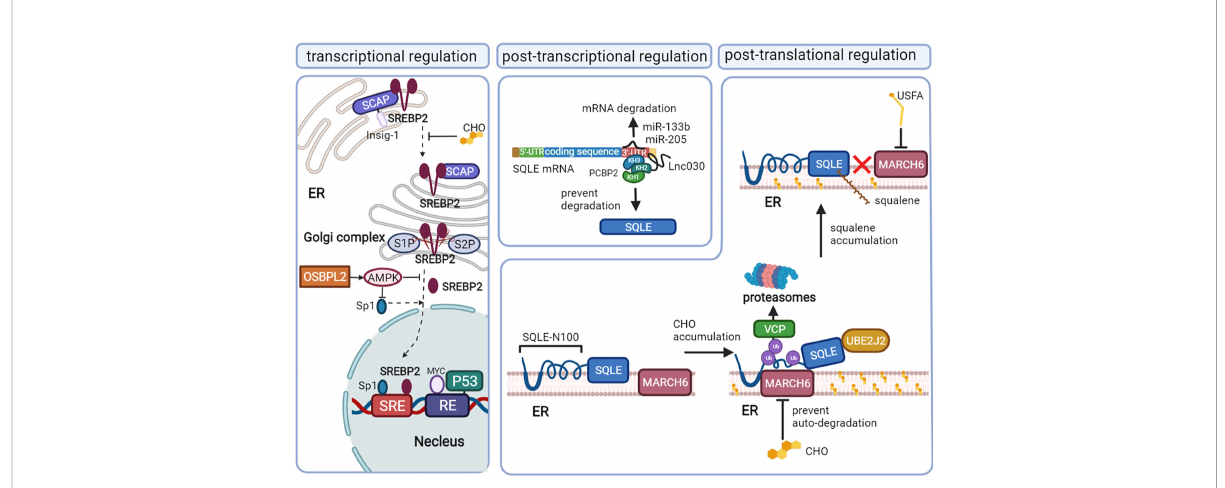
FIGURE 2 The mechanisms that regulate SQLE expression in cancer. Squalene monooxygenase (SQLE) can be regulated at the transcriptional level mainly via sterol regulatory element-binding protein 2 (SREBP2), the posttranscriptional level via microRNA (miRNA)/long noncoding RNA (lncRNA), and the posttranslational level via cholesterol feedback regulation. Mature SREBP2 promotes the transcription of SQLE by binding to the sterol- regulatory elements (SREs) of sqle (the gene encoding SQLE). When the cholesterol content in the endoplasmic reticulum membrane decreases, the SREBP2/SCAP complex dissociates from Insig-1 on the endoplasmic reticulum (ER) and is convoyed to the Golgi complex, where SREBP2 is cleaved by site-1 protease (S1P) and site-2 protease (S2P) and releases the mature form in the Golgi complex. Oxysterol binding protein like 2 (OSBPL2) de fi ciency can promote SREBP2 and speci fi city protein (Sp1) activation by inhibiting AMPK. P53 and MYC also regulate SQLE at the transcriptional level. MiR-133b and miR-205 promote SQLE mRNA degradation, while Lnc030 prevents SQLE mRNA degradation by forming a poly(rC) binding protein 2 (PCBP2)/Lnc030/SQLE 3 ’ -UTR complex. Cholesterol (CHO) feedback regulation occurs via ubiquitin-proteasomal degradation of SQLE, which requires ubiquitin-conjugating enzyme E2 J2 (UBE2J2), membrane-associated RING fi nger 6 (MARCH6) and conformational change of SQLE N-100. Valosin-containing protein (VCP) extracts SQLE from the ER to proteasomes. Squalene and unsaturated fatty acids (USFAs) can disrupt the interaction between SQLE N-100 and MARCH6 by regulating SQLE and MARCH6, respectively, and suppress ubiquitin-proteasomal